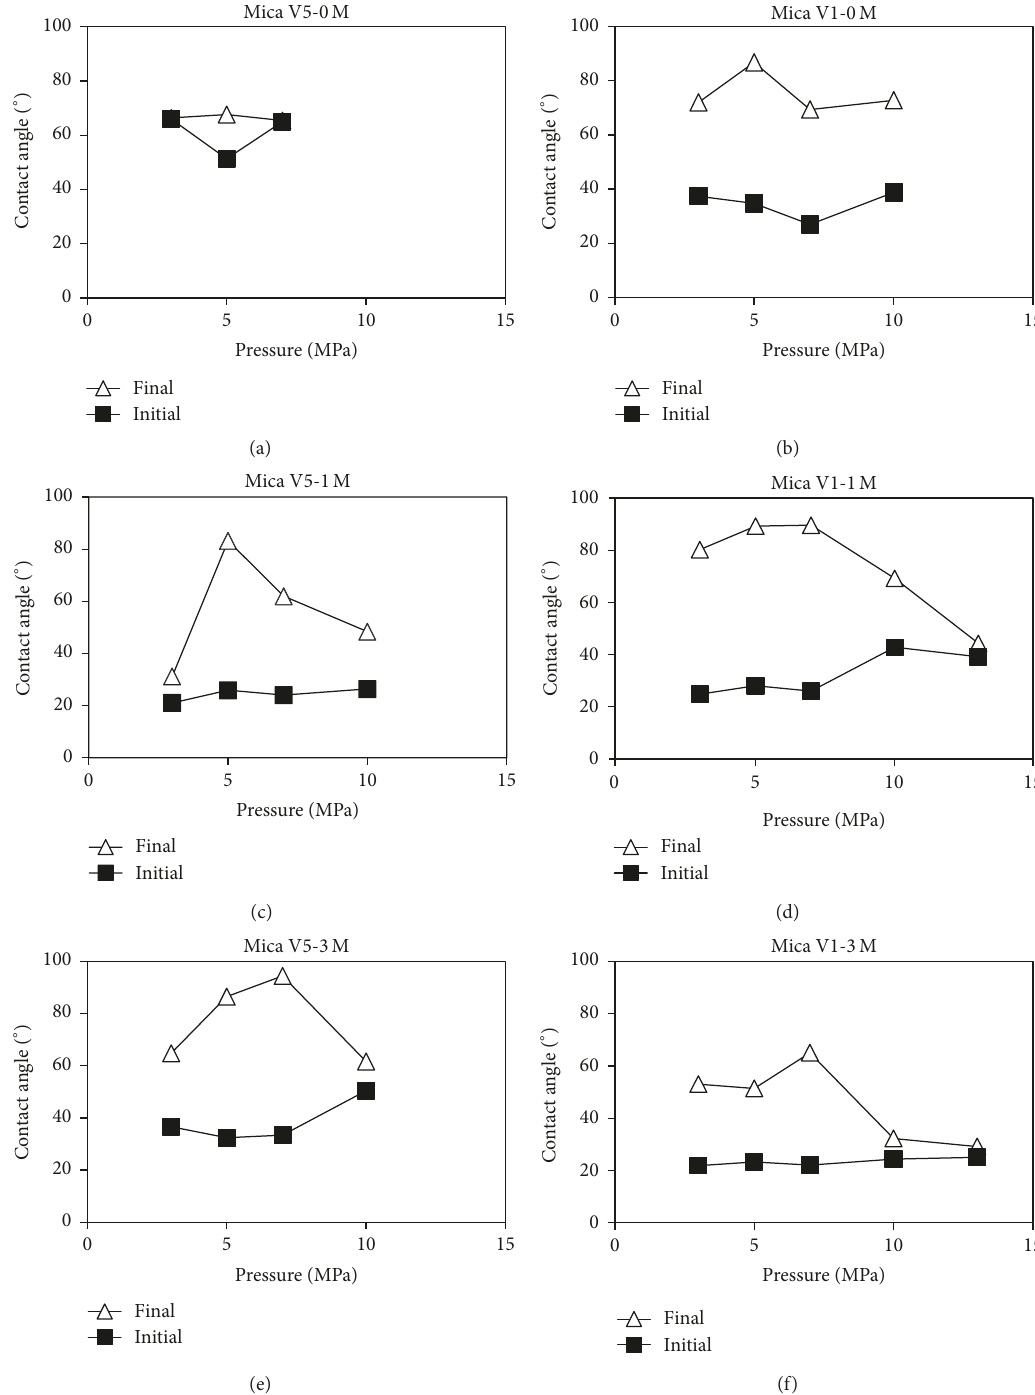
Figure 3: Variations of initial and final contact angles with pressure. (a) Type V5 with deionized water, (b) type V1 with deionized water, (c) type V5 with 1MNaCl, (d) type V1 with 1MNaCl, (e) type V5 with 3 MNaCl, and (f) type V1 with 3